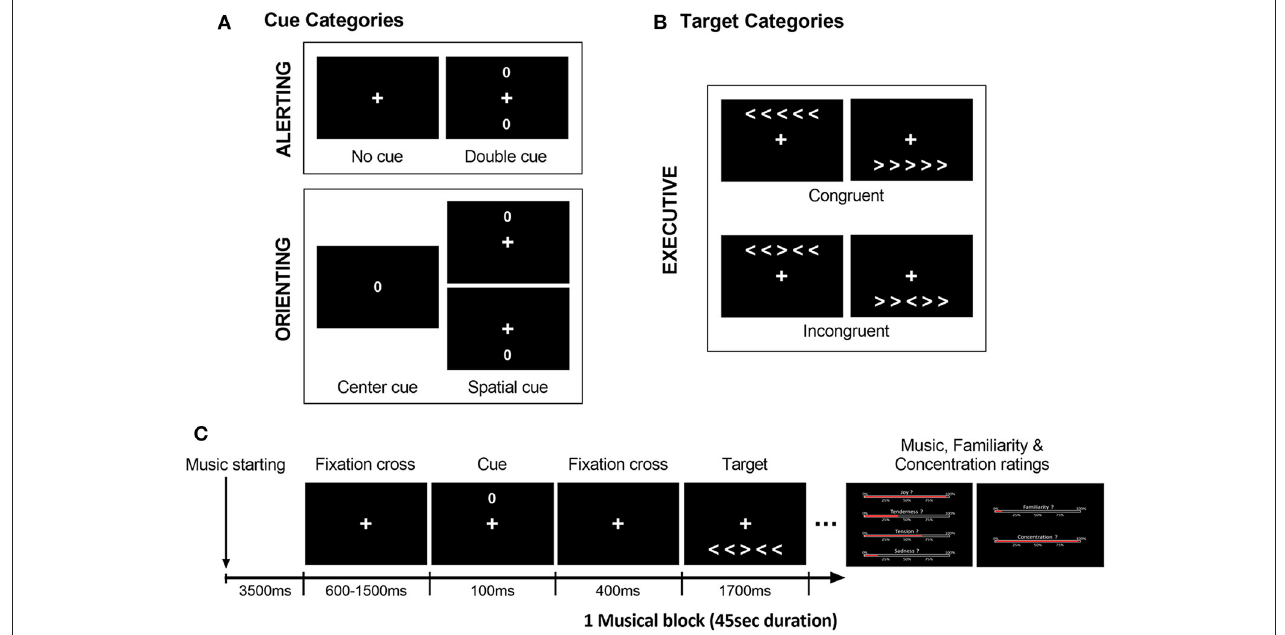
FIGURE 1 | Illustration of the modified ANT design, with distinct (A) cue categories and (B) target categories used to assess the executive, alerting, and orienting components of attention. (C) Example of a typical trial time-course at the beginning of a block (here musical block), with an empty 3,500ms interval prior to the first trials. All trials began with a cue presentation (spatially invalid cue here), followed by the target display (incongruent condition here). Participants had to indicate the direction of the central arrow of the target (right or left) as fast and as accurately as possible after its presentation (within 1,700ms max). Music, familiarity and concentration ratings for the preceding musical excerpt were presented after the blocks (i. emotion intensity for joy, tenderness, tension and sadness, ii. familiarity, and iii.